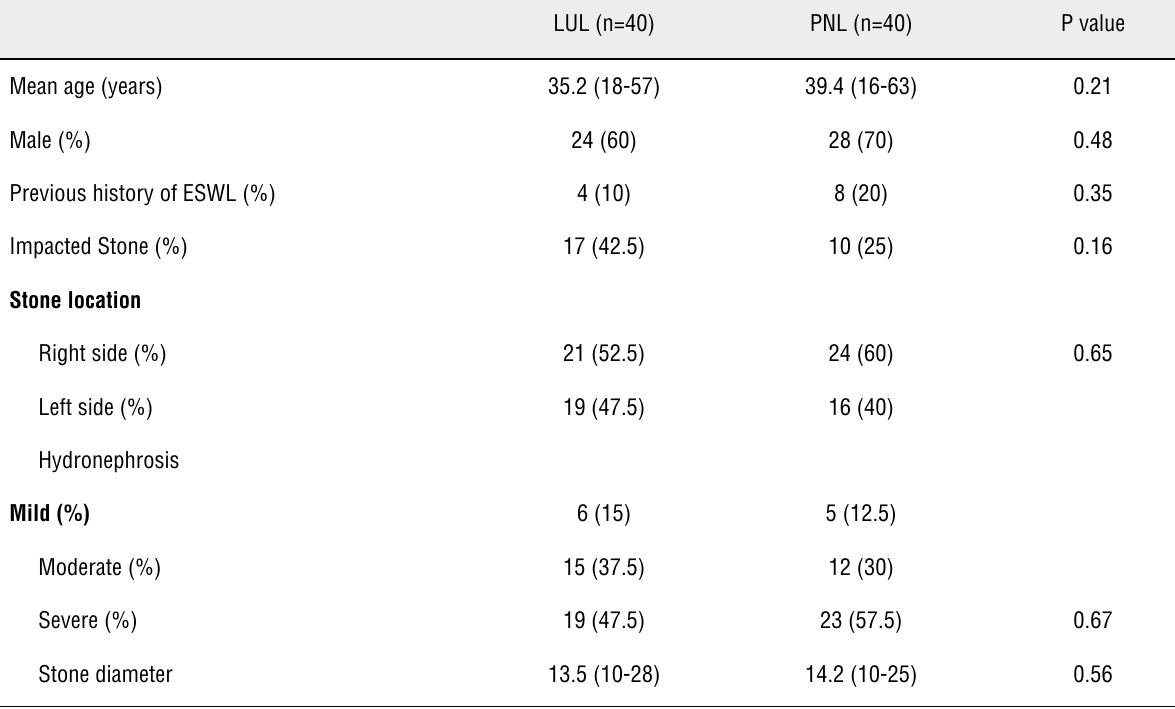
Table 1 - Demographic and clinical characteristics of